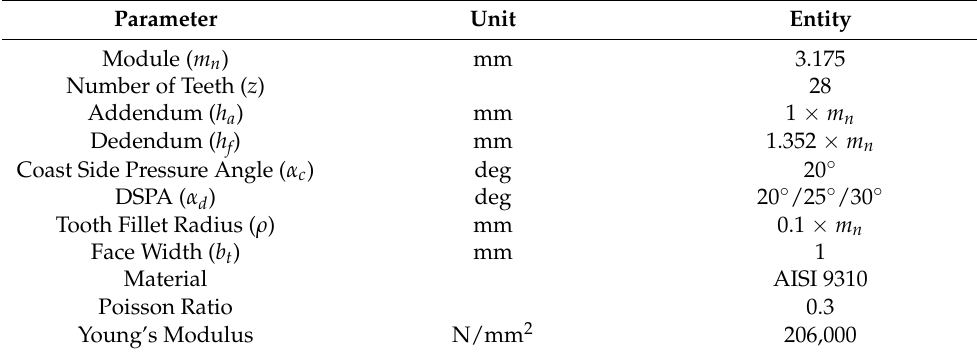
Table 1. Gear design parameters [8].